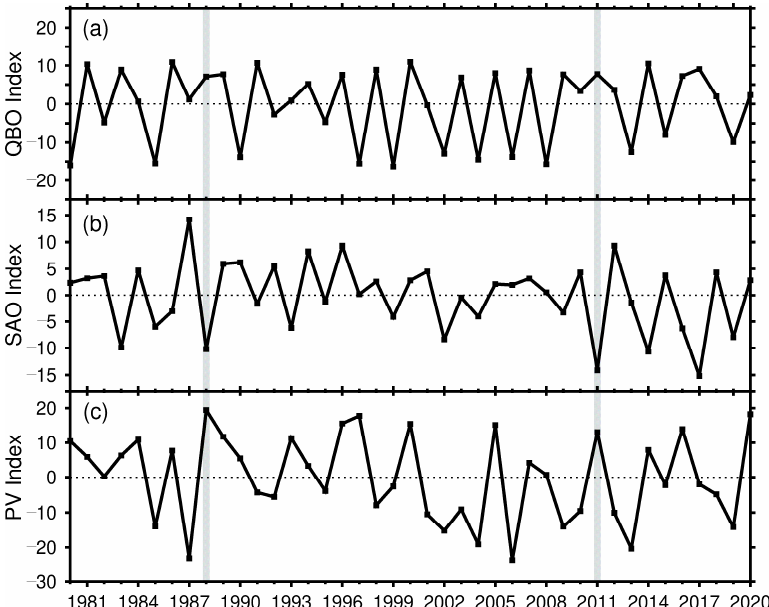
Figure 6. ( a ) QBO and ( b ) SAO indices averaged from November to February and ( c ) PV index averaged in January–February from 1980 to 2020 based on the ERA5 re-analysis dataset. The main characteristic of the meridional circulation associated with the SAO is the existence of tropical areas of convergence and divergence, which are produced by a neg ‐ ative and positive anomaly in the meridional wind in the NH tropical zone [55,74]. To confirm the effect of the SAO on the strengthening deep branch of the residual circulation, month ‐ to ‐ month evolution of the meridional wind anomalies from November 2010 to April 2011 are shown in Figure 7. From November 2010 to February 2011, significant pos ‐ itive meridional wind anomalies were found in the NH tropical upper stratosphere, and negative meridional wind anomalies were found in the NH tropical lower stratosphere (Figure 7a–d), corresponding to the convergence and divergence zones, respectively. The existence of these convergence and divergence zones corresponded to the rising and sink ‐ ing motions. The rising motion over the tropical wind shear zones and sinking motions over the subtropics and mid ‐ latitudes, added to the meridional divergence and conver ‐ gence motions, formed a clockwise circulation cell (vectors in Figures 4a–d and 5a–d). Until March 2011, the positive meridional wind anomalies in the tropical upper strato ‐ sphere became weak; thus, the corresponding clockwise circulation cell disappeared (Fig ‐ ures 4e, 5e and 7e).